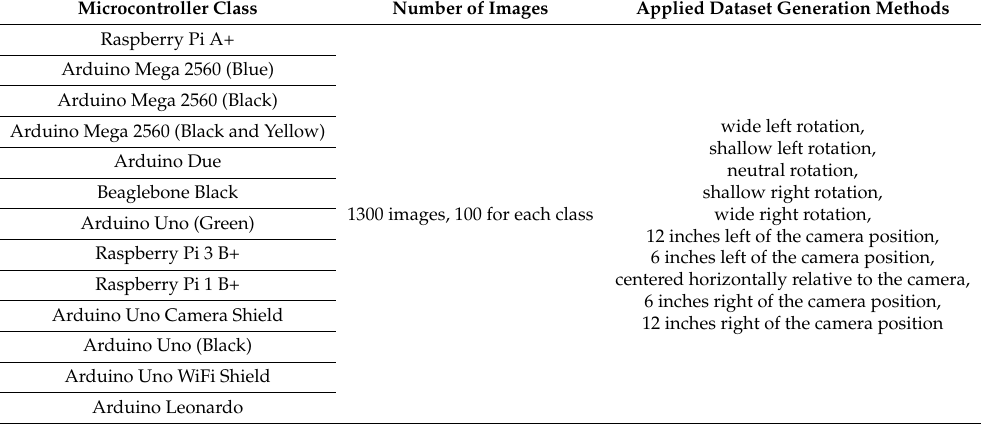
Table 1. Description of the original dataset together with the associated generation actions.